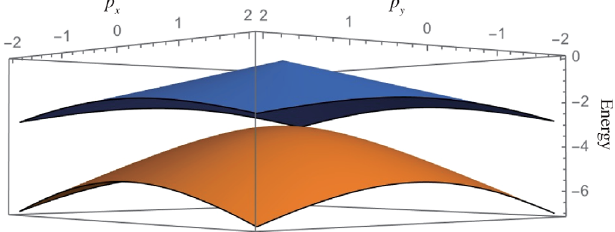
FIG. 3. The exact many-body spectrum (including the ground state and the first excited state) of the